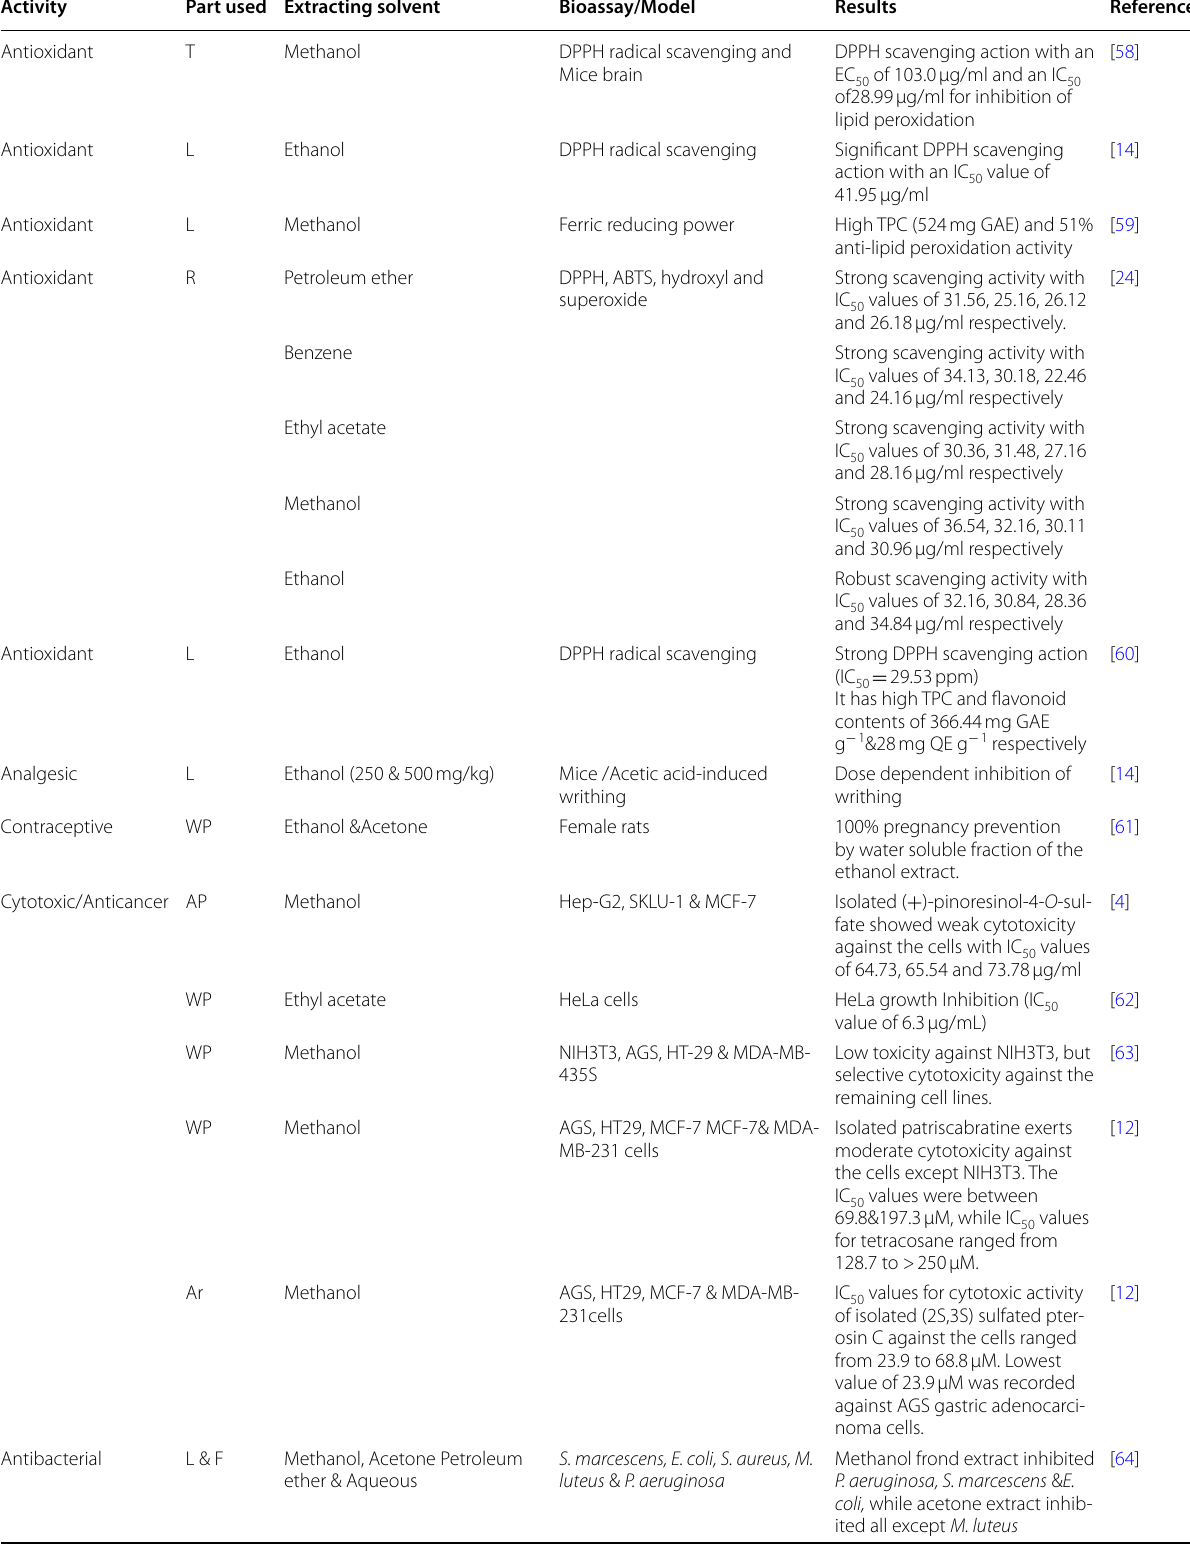
Table 4 Biological activities of Acrostichum aureum